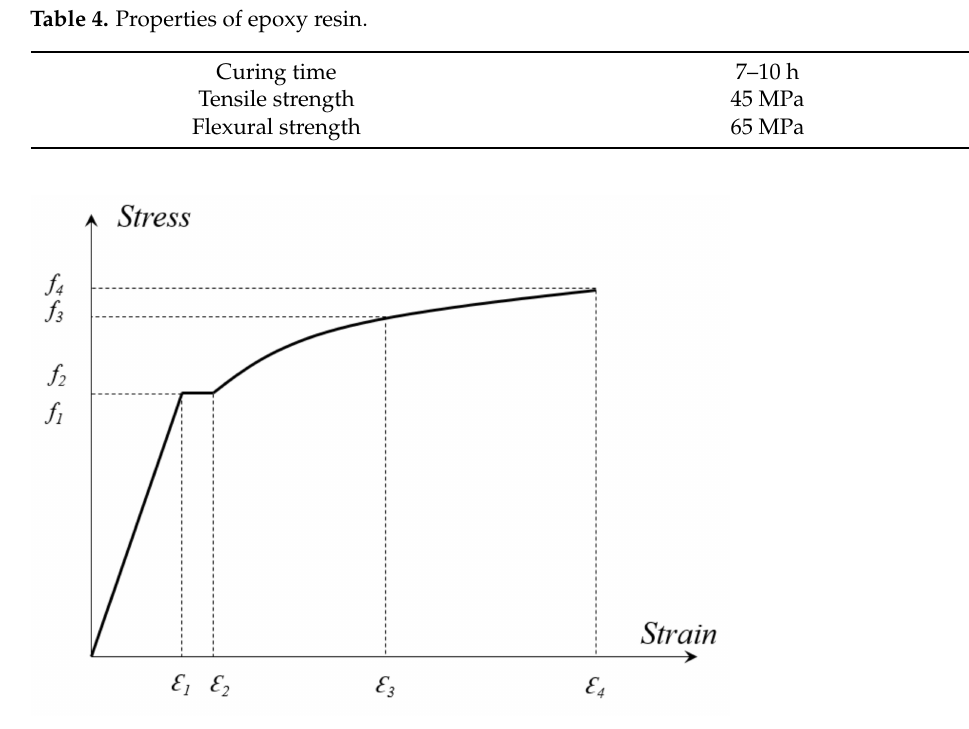
Figure 4. Typical stress-strain curve of steel bars.